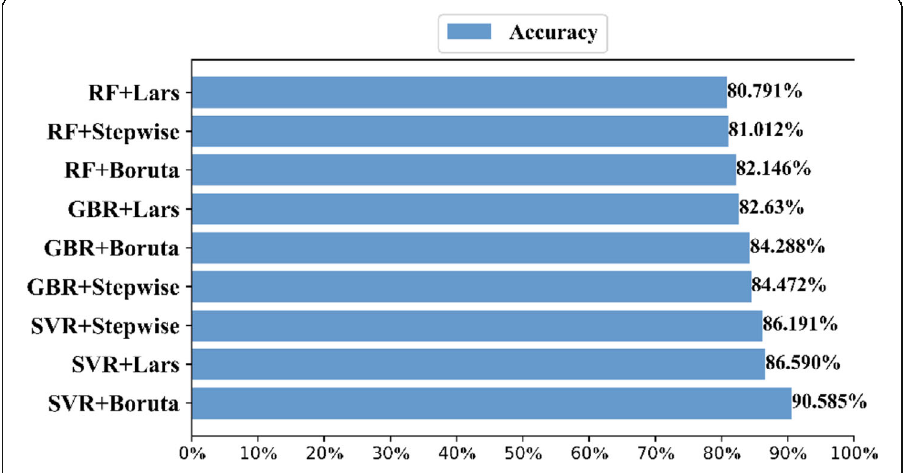
Fig. 4 The accuracy comparison of nine hybrid models